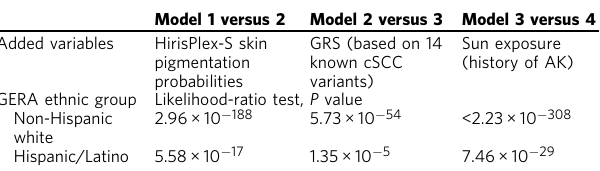
Table 4 Model comparison analyses using likelihood- ratio